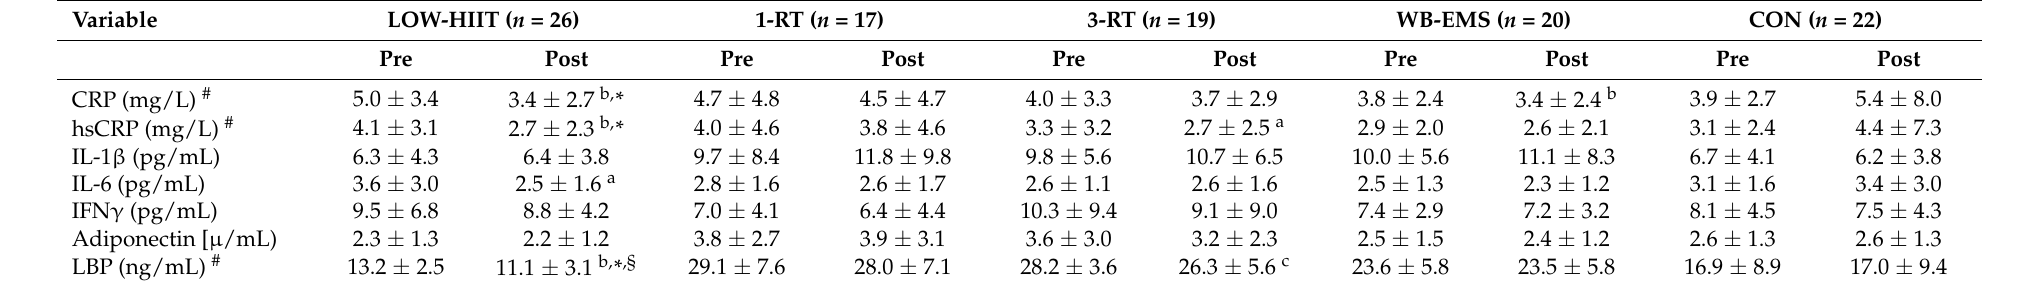
Table 4. Inflammatory markers before and after the intervention.